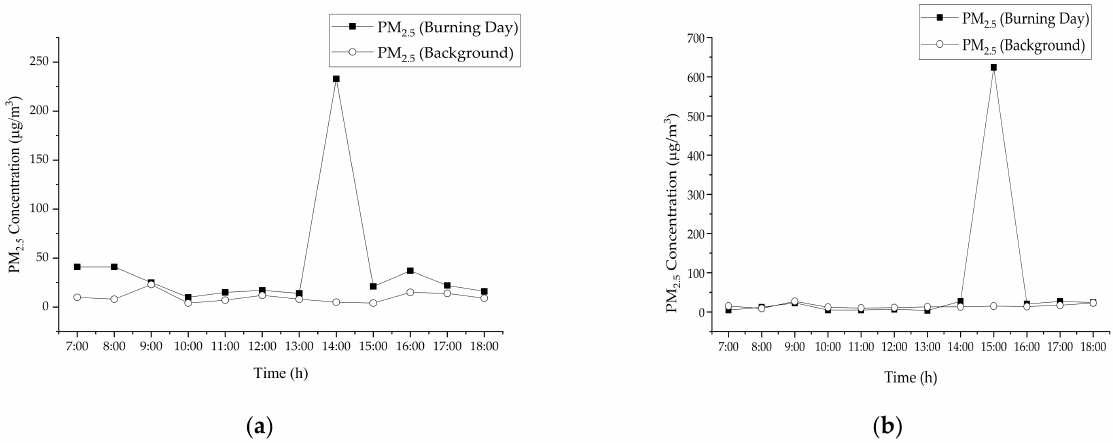
Figure 3. Concentration of ambient PM 2.5 during rice straw burning activity ( a ) Site 1 ( b ) Site